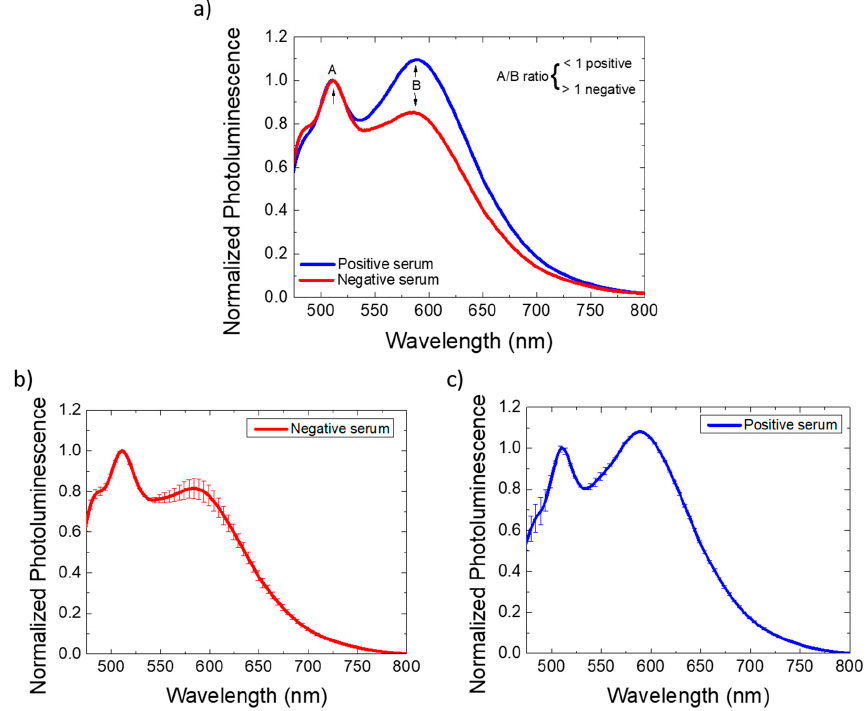
Figure 6. ( a ) Normalized photoluminescence spectrum of the optical biosensor making the peak ratio. The peak ratio between bands A and B (A/B) was <1 to the COVID-19 positive serum, while the negative serum sample had an A/B ratio > 1. Comparison of the photoluminescence spectra of the devices using blood sera diluted 1000 and 3000 times: ( b ) negative sera and ( c ) positive sera.